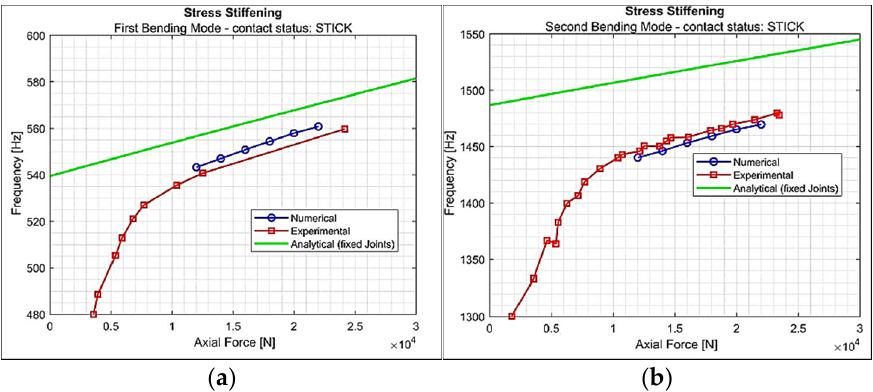
Figure 18. Obtained frequencies from experimental, numerical, and analytical approaches: ( a ) first flexural mode and ( b ) second flexural mode.